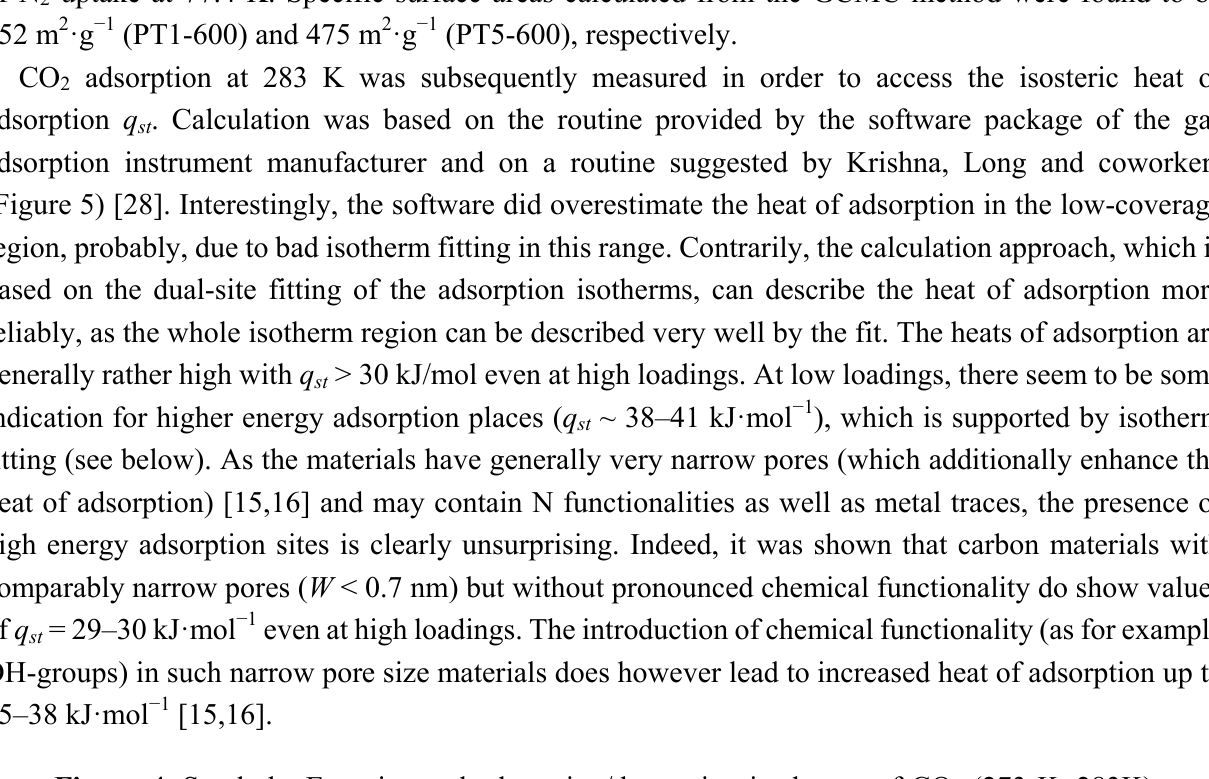
Figure 4. Symbols: Experimental adsorption/desorption isotherms of CO and N (273K) of PT1-600 (left plot) and PT5-600 ( a ); Lines: predicted adsorption isotherms 2 and N at 273K of PT1-600 ( b ) and PT5-600 (right plot) as determined from ideal of CO 2 2 adsorbed solution theory (IAST) modeling (gas composition: 0.15/0.85 CO